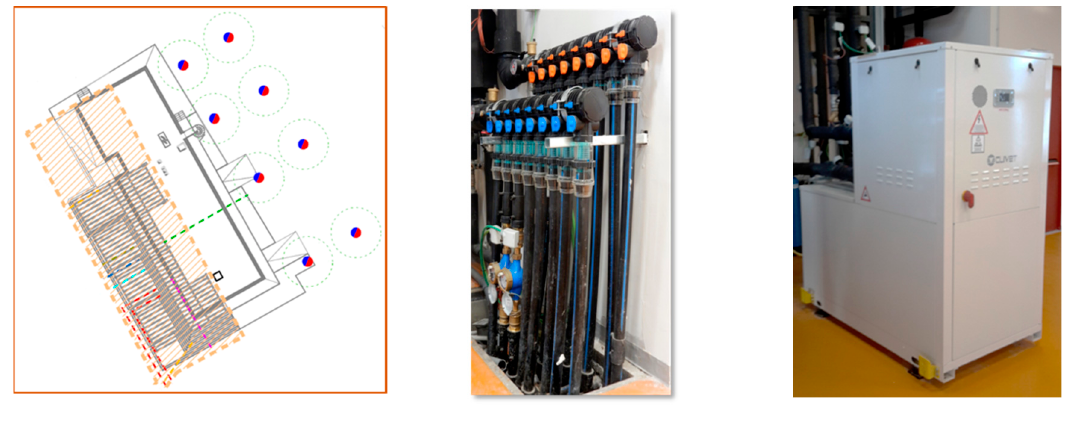
Figure 5. The geothermal plant.